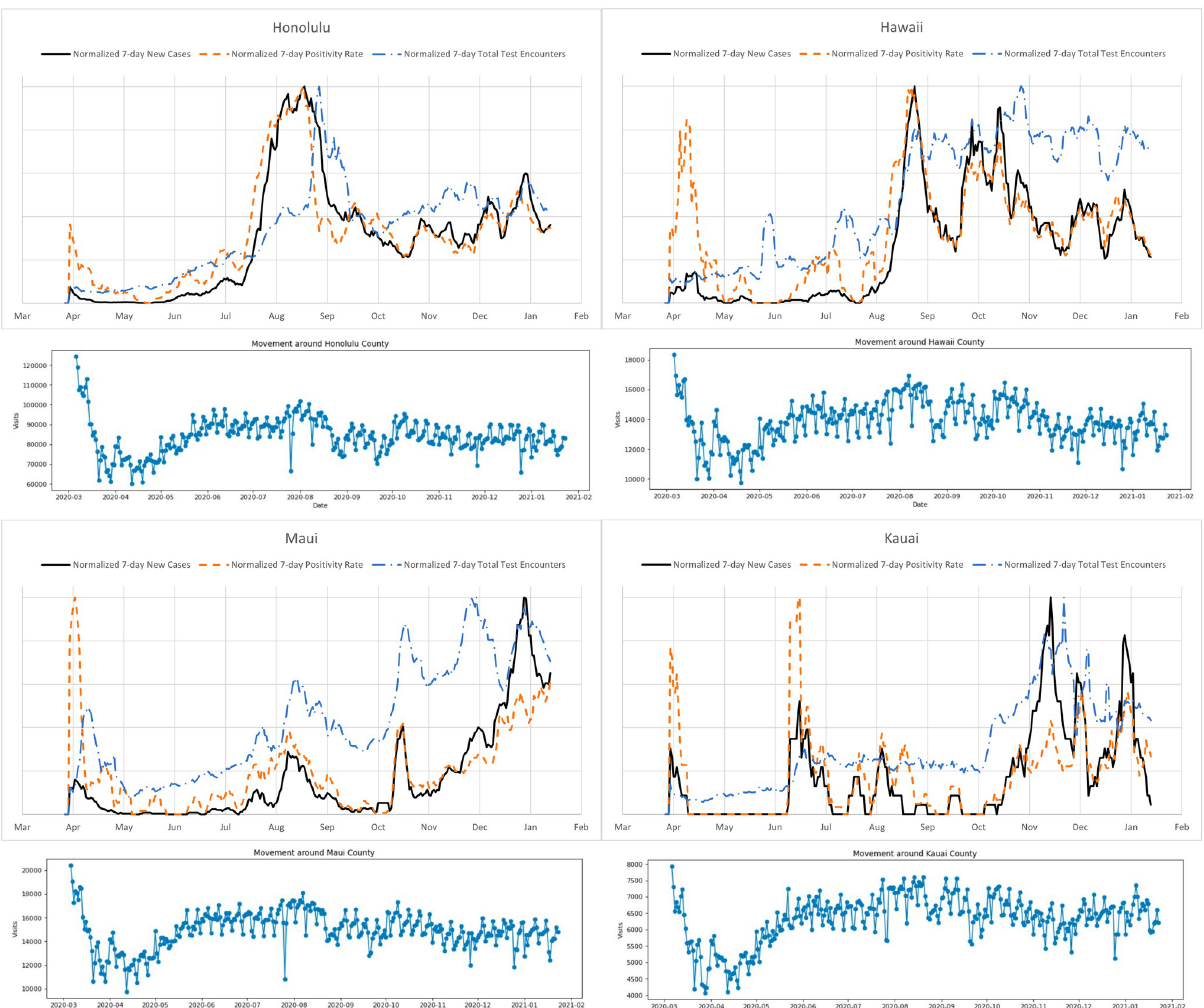
Fig 7. Testing, positivity and mobility plots. A: Honolulu. A sharp increase in the test positivity rate (along with the daily cases) in July indicates an outbreak of the disease. The later decrease in the positivity rate with the increased number of tests indicates a substantial slowdown of the spread of the disease. B: Hawaii. A sharp increase in the test positivity rate around August indicates an outbreak the disease. The later decrease in the positivity rate with the number of tests hovering around the same value indicates a welcome slowdown of the spread of the disease. Maui: A series of ups and downs in the test positivity rate and the number of daily cases indicate the occurrences of outbreaks of the disease. The significant increase in these numbers at the beginning of this year suggests a serious spread of the virus. A noticeable jump in the daily case number that does not correlate with the positivity rate can be explained by a jump in the number of tests, since the latter are performed for people with higher chances of having the virus. C: Kauai. The number of daily cases and test positivity rate are still well correlated, even though the raw numbers are small. Similar to Hawai‘i county, we can see a jump in the daily case numbers that correlates with the increased number of tests rather than the test positivity rate, which is likely due to the biased nature of the population sample on which the tests are performed. Overall mobility suggest a modest correlation with the number of daily cases. It shows a major dip in mobility triggered by the first stay-at-home order back in March 2020. The mobility data clearly suggests why the second lockdown was not as efficient as the first one.